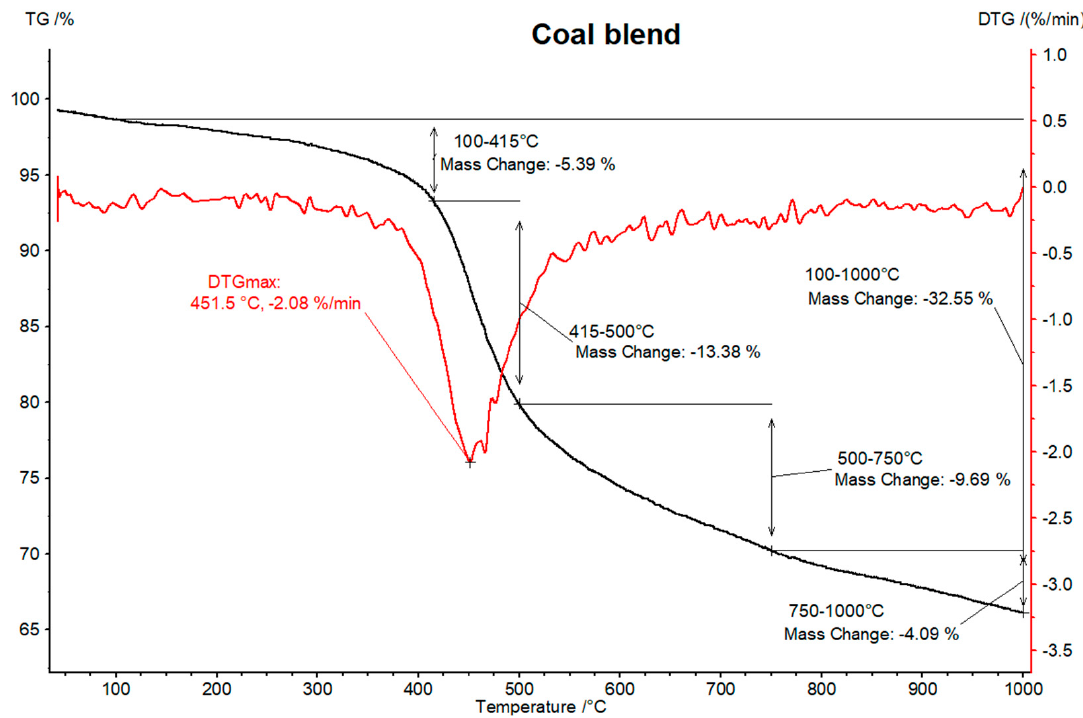
Figure A1. TG/DTG curves obtained for coal blend.